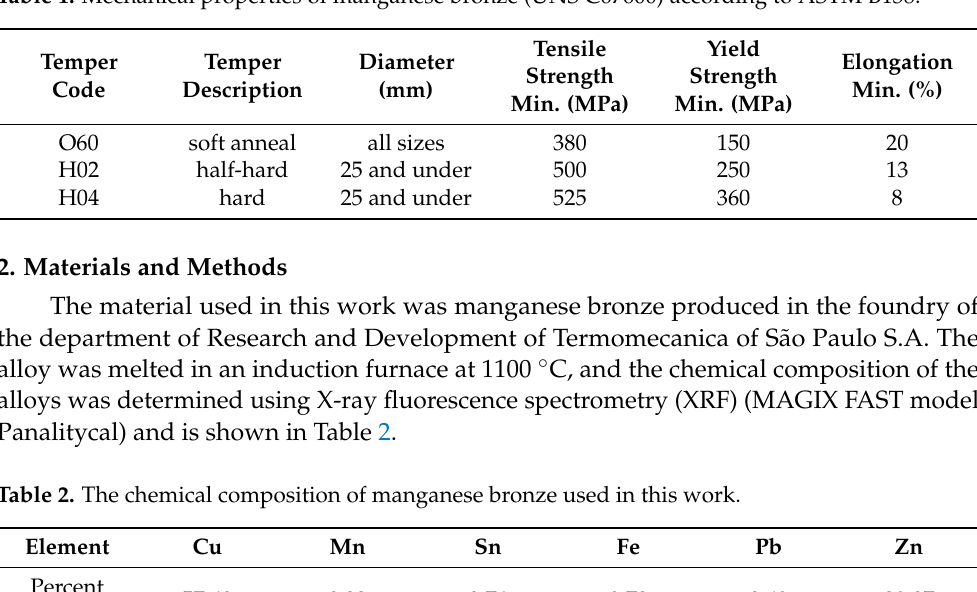
Table 1. Mechanical properties of manganese bronze (UNS C67600) according to ASTM B138.